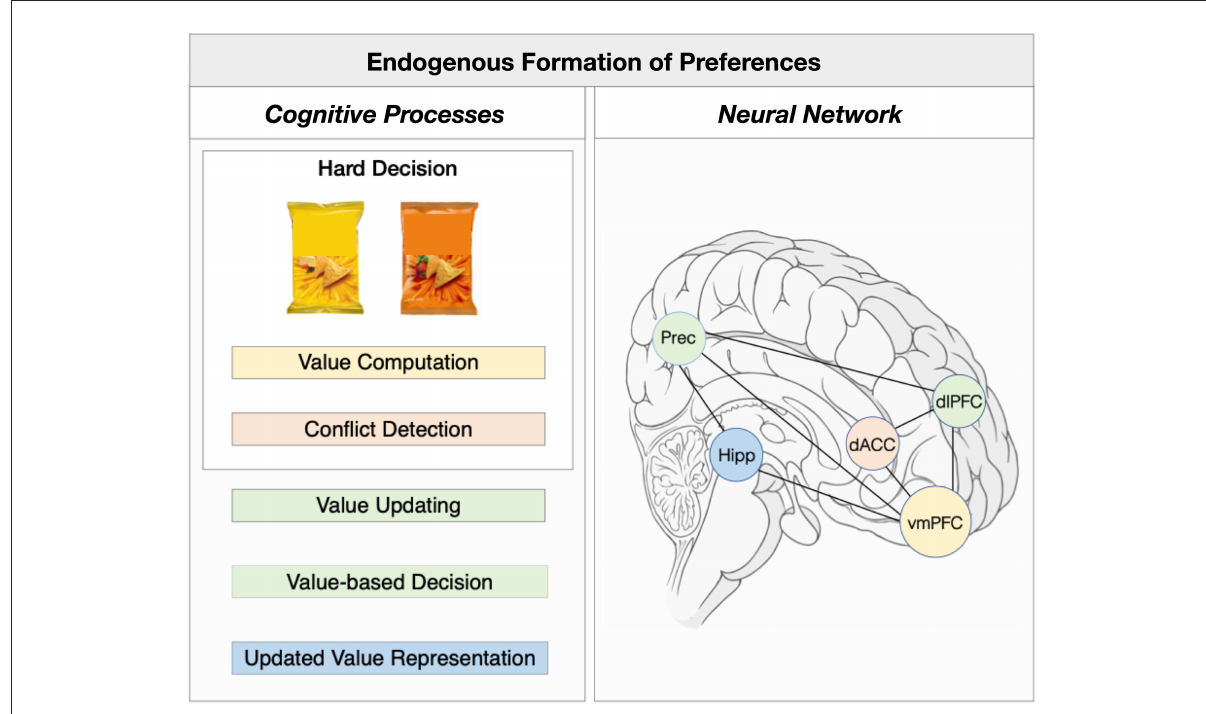
FIGURE1 Integrative neural model underlying endogenous preference formation. Left Panel: The underlying cognitive mechanisms of choice-induced preference change effects can be described into four main processing steps: (1) value computation (orange) (2) conflict detection (red), (2) value updating and (3) value-based decision (green), (4) updated value representation (blue). Right Panel: Neural regions and networks associated with the cognitive processing steps of choice-induced preference change effects. Colors of cognitive processes match the neural correlates as depicted in the neural processes. Hipp, Hippocampus; Prec, Precuneus; dACC, dorsal anterior cingulate cortex; vmPFC, ventromedial prefrontal cortex; dlPFC, dorsolateral prefrontal